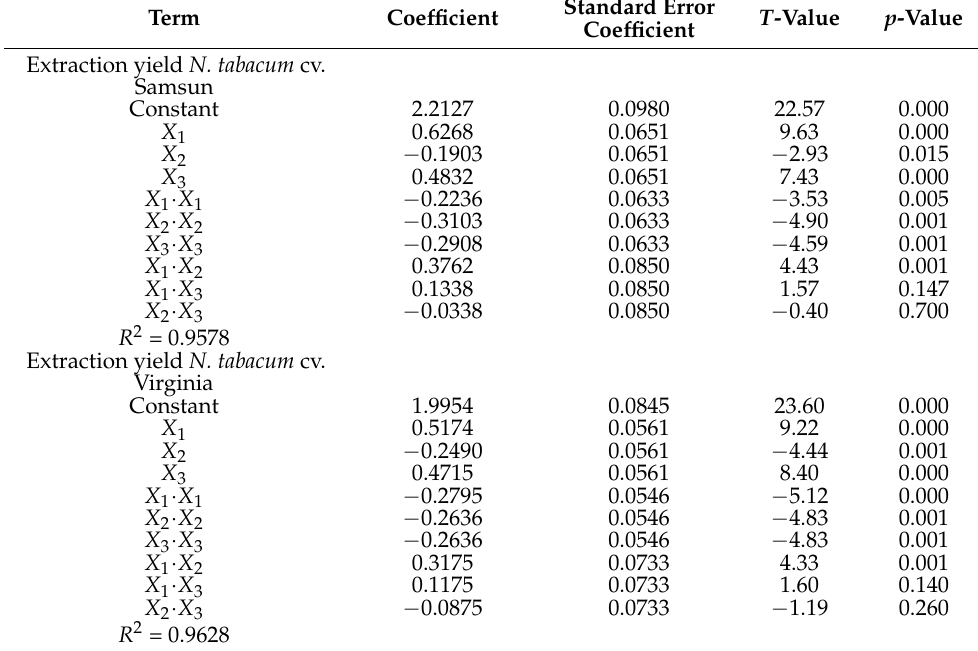
Standard Error T -Value p -Value Coefficient